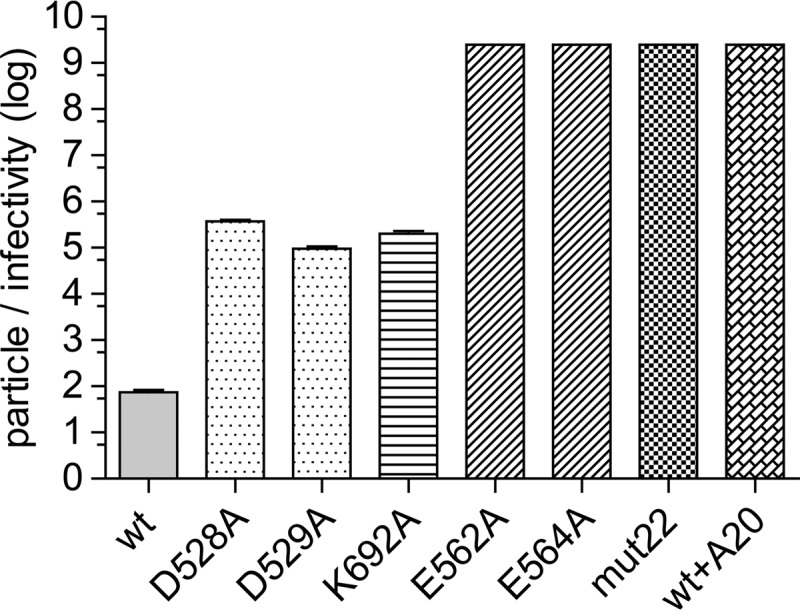
Particle-to-infectivity ratios of mutants carrying a single-stranded GFP expression cassette. Shown are log particle-to-infectivity ratios of the six mutants in this study compared to the wt and the wt complexed with the A20 antibody. The particle-to-infectivity ratio is the ratio of the number of DNase-resistant particles per milliliter (determined by RT-PCR) divided by the number of transduced green cells per milliliter of virus in the presence of a coinfecting adenovirus. Each bar represents the mean of data from three experiments; error bars indicate standard errors. Mutants with no error bars showed no detectable infectivity, and therefore, the particle-to-infectivity ratio is >2.5 × 109. One-way ANOVA was used to determine statistical significance (F[7,16] = 68; P < 0.0001; n = 3). Tukey's post hoc results indicated that all comparisons with the wt had P values of <0.001, except for comparisons of the wt versus the D529A mutant, where the P value was <0.01.